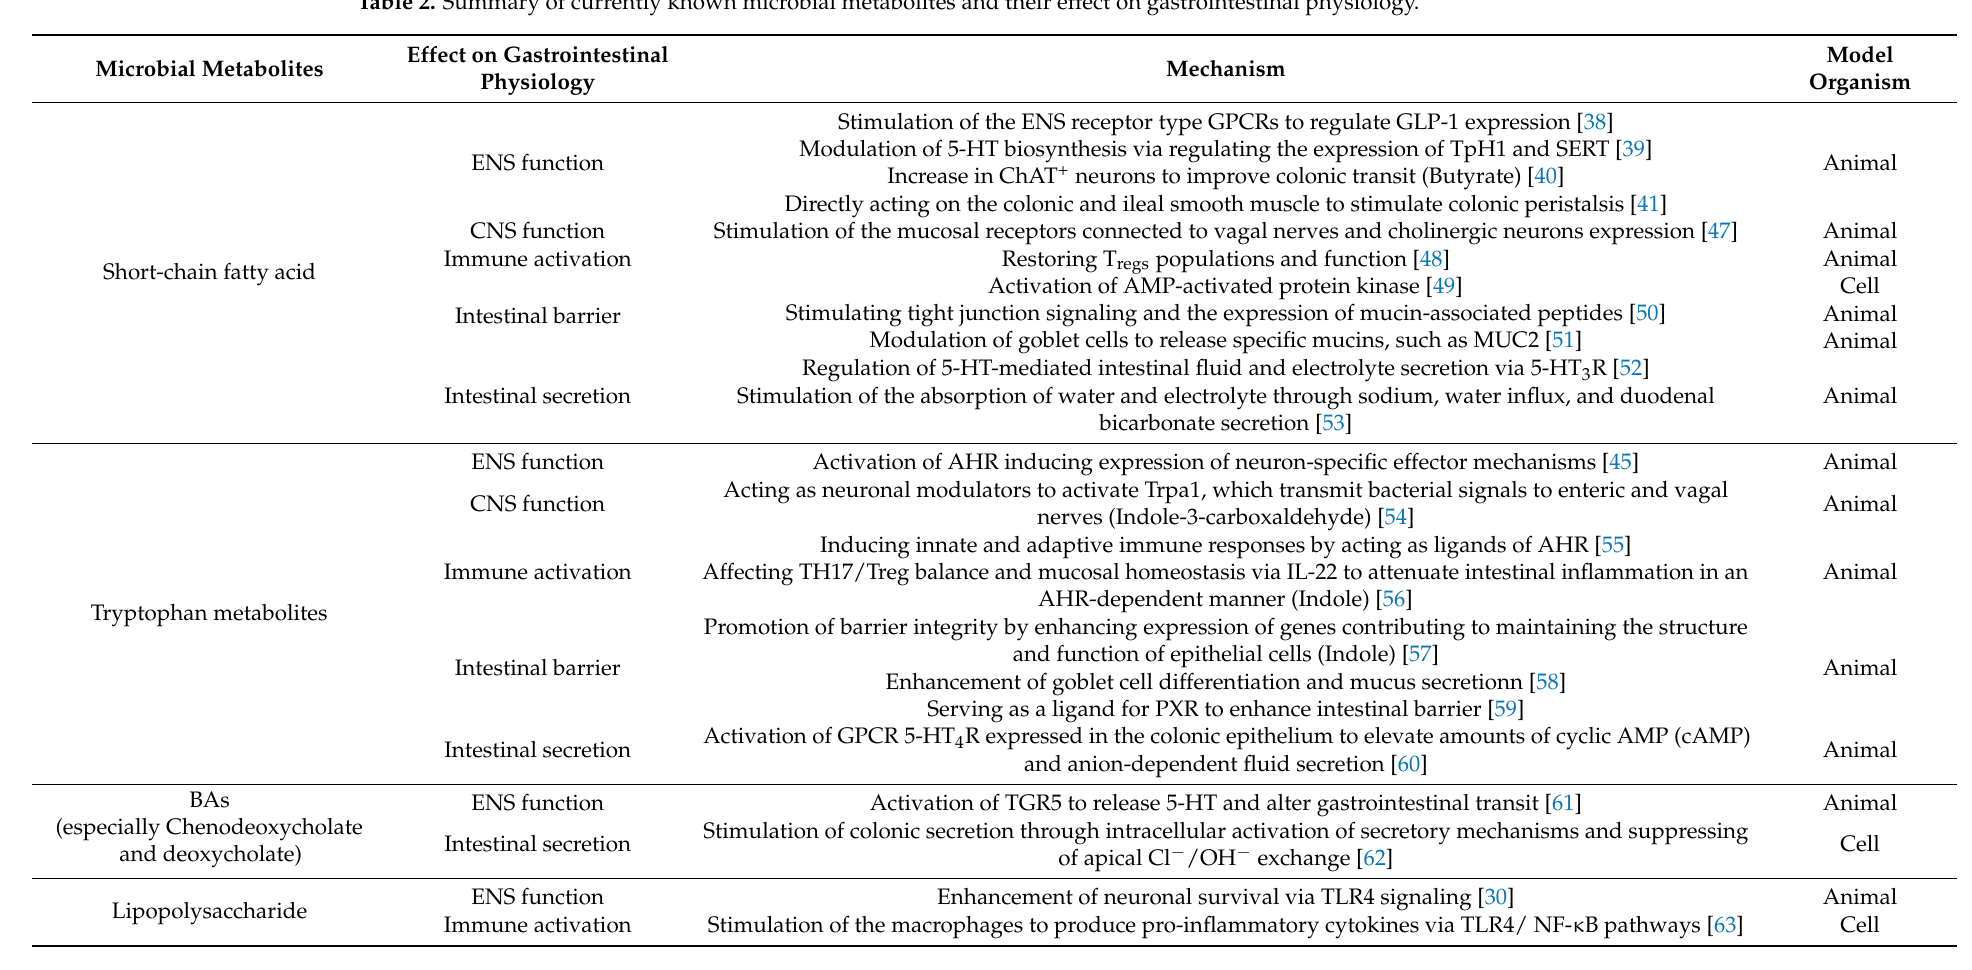
Table 2. Summary of currently known microbial metabolites and their effect on gastrointestinal